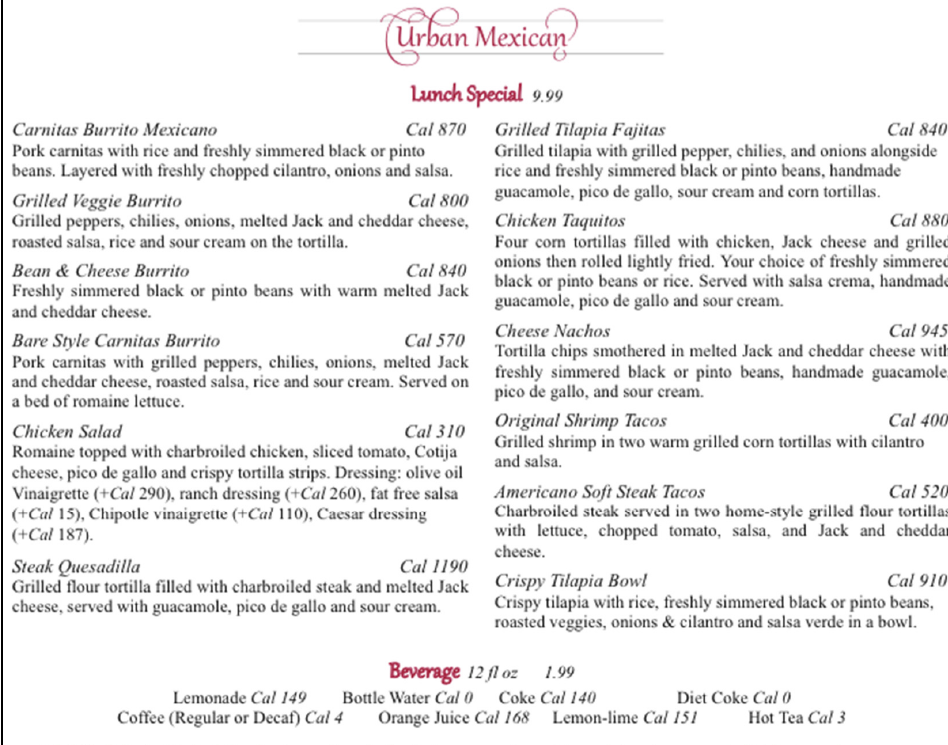
Figure A9. Urban Mexican Control Menu.